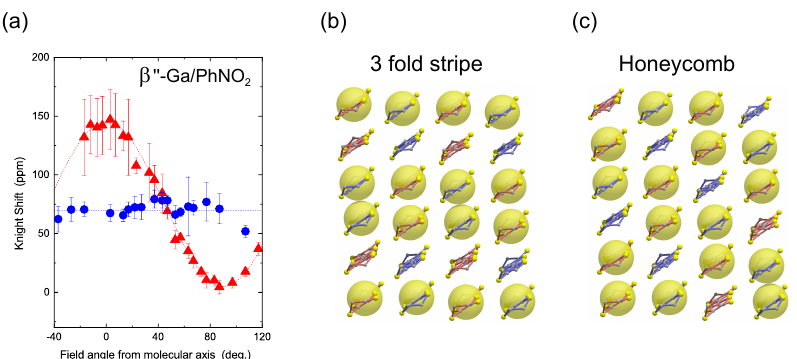
Figure 7. ( a ) Field direction dependence of Knight shift [48]. The field direction is defined with respect to the molecular long axis. The large amplitude for R sites indicates rich charge filling to the BEDT-TTF π orbital. ( b , c ) Schematic images of charge patterns in the conducting plane. The yellow balls on BEDT-TTF molecules indicate charge-rich (R) sites. The vertical P-R-R pattern can be aligned horizontally to make stripes ( b ), or shifted by one site to form a honeycomb structure ( c